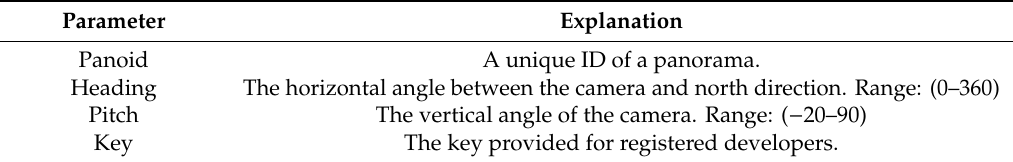
Table 3. Explanation of some parameters in the street view Application Program Interface